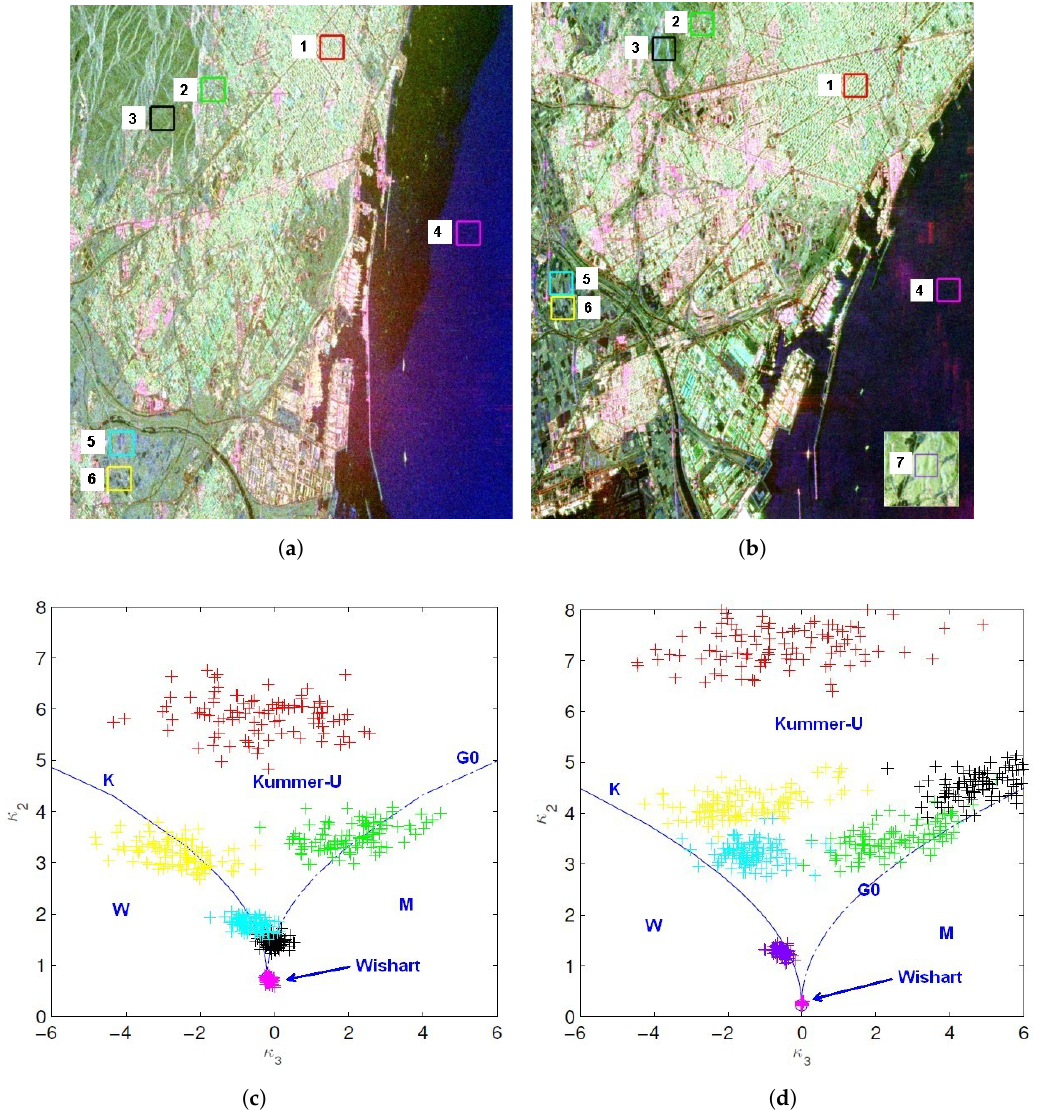
Figure 4. Matrix variate log-cumulants of the 2nd and the 3rd order estimated from a RADARSAT-2 data and an ALOS-2 data. Theoretical values calculated from the K , the G 0 , the Kummer- U , the W , the M and the Wishart distributions are also plotted as references. ( a ) ROIs of the RADARSAT-2 data. ( b ) ROIs of the ALOS-2 data. ( c ) Matrix variate log-cumulants of the RADARSAT-2 data. ( d ) Matrix variate log-cumulants of the ALOS-2